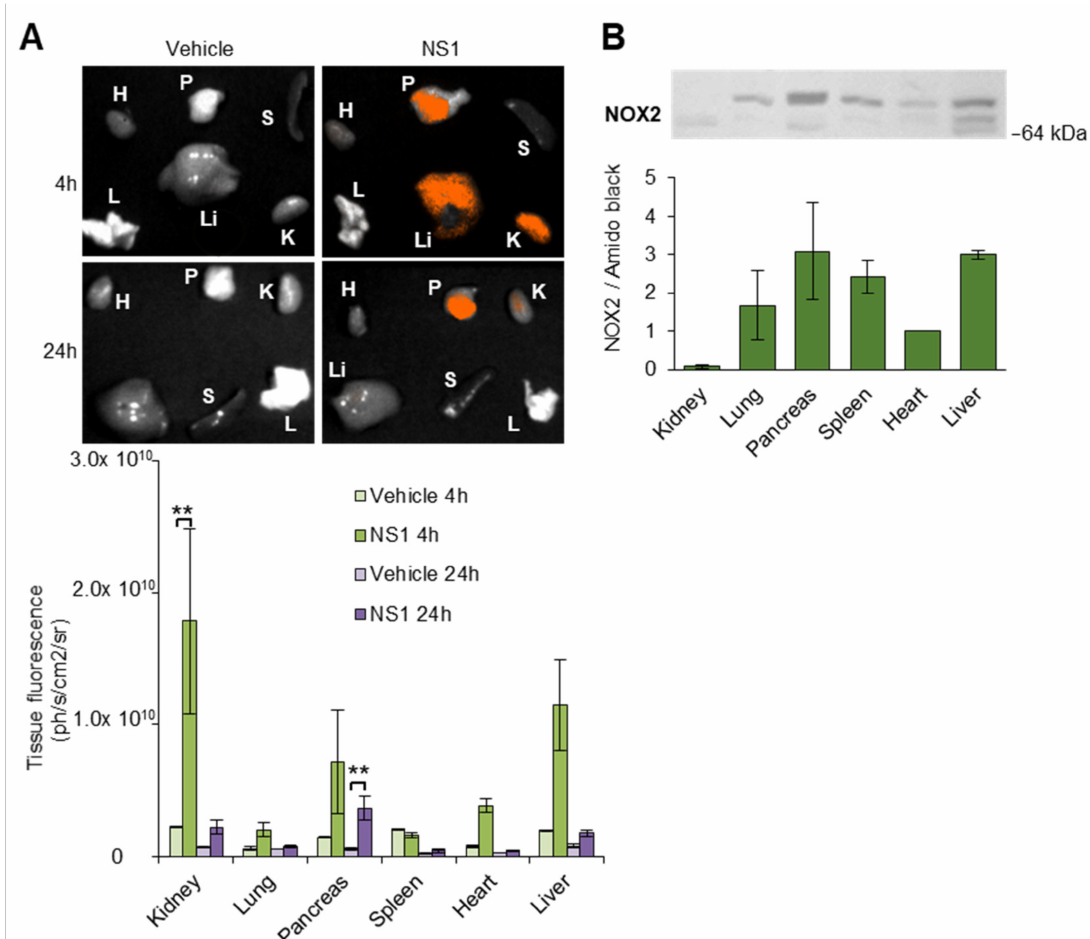
Figure 3. ( A ) NS1 fluorescence (excitation at 465 nm, emission at 620 nm) in selected organs of the mice after sacrifice at 4 h and 24 h post-IP relative to vehicle alone and their quantification. ( B ) NOX2 levels at 4 h in these organs determined by Western blots and their quantification relative to amino black presented in Supplementary Figure S7. The staining with amido black of the total proteins transferred onto the nitrocellulose membrane is used to normalize the levels of the protein of interest (i.e., NOX2) in each tissue analyzed. This normalization was used because any housekeeping proteins, such as β -actin or β -tubulin, show variable levels between tissues. Statistical significance indicated by stars (** p -value < 0.01) was evaluated by a two-way ANOVA followed by Tukey’s multiple comparisons test. A significant accumulation of NS1 was observed in the kidney after 4 h post-injection while at 24 h post-injection, NS1 fluorescence was significantly increased in the pancreas. No significant fluorescence of NS1 was noted in all other tissues